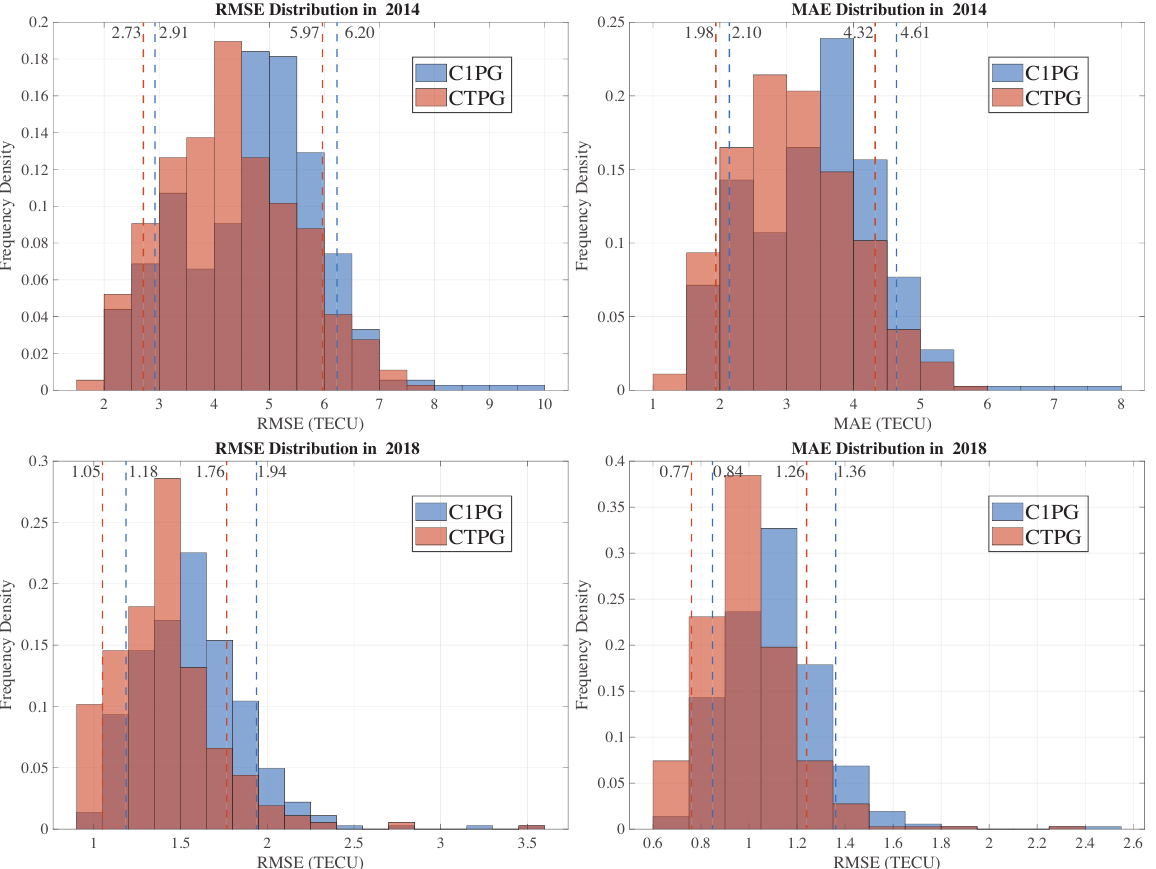
Figure 5. The errors distribution of C1PG and CTPG in 2014 and 2018. Table 3 demonstrates the mean RMSE and MAE values of CTPG and C1PG in high latitude (87.5 ◦ S(N)–60 ◦ S(N)), middle latitude (57.5 ◦ S(N)–30 ◦ S(N)) and low latitude (27.5 ◦ S–27.5 ◦ N) regions in 2014 and 2018. It can be seen that the RMSE and MAE values of CTPG are smaller than those of C1PG in all three regions, and the difference is more pronounced in the high and middle latitude regions. Taking the RMSE values in 2014 as an example, the RMSE of CTPG decreased by 16.6% and 15.4% in the high and middle latitude regions, respectively, compared with the RMSE of C1PG, but only decreased by 1.8% in the low latitude region. This illustrates that CAiTST performs better at middle and high latitudes than at low